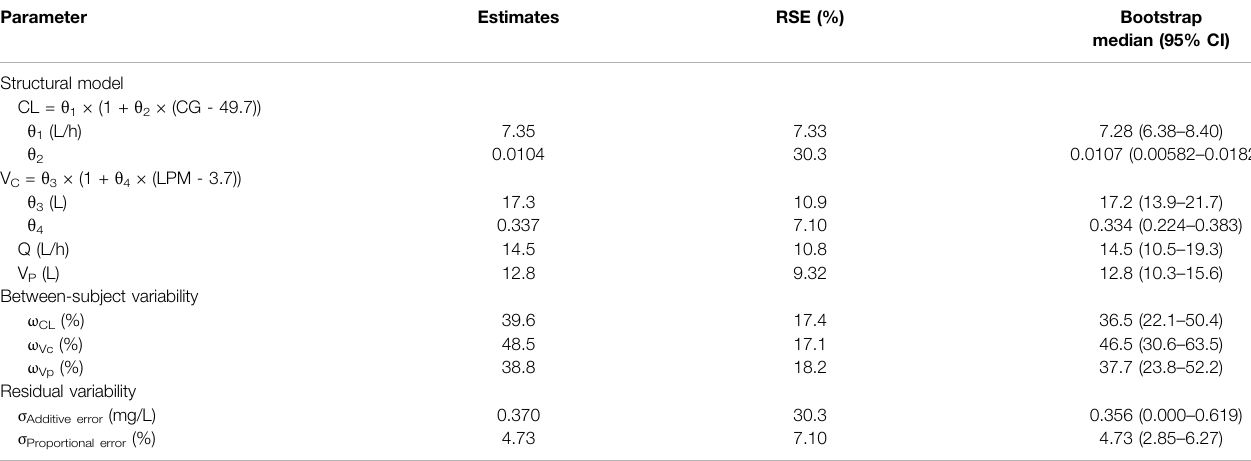
TABLE 2 | Population PK parameter estimates for meropenem in ECMO patients a . Parameter Estimates